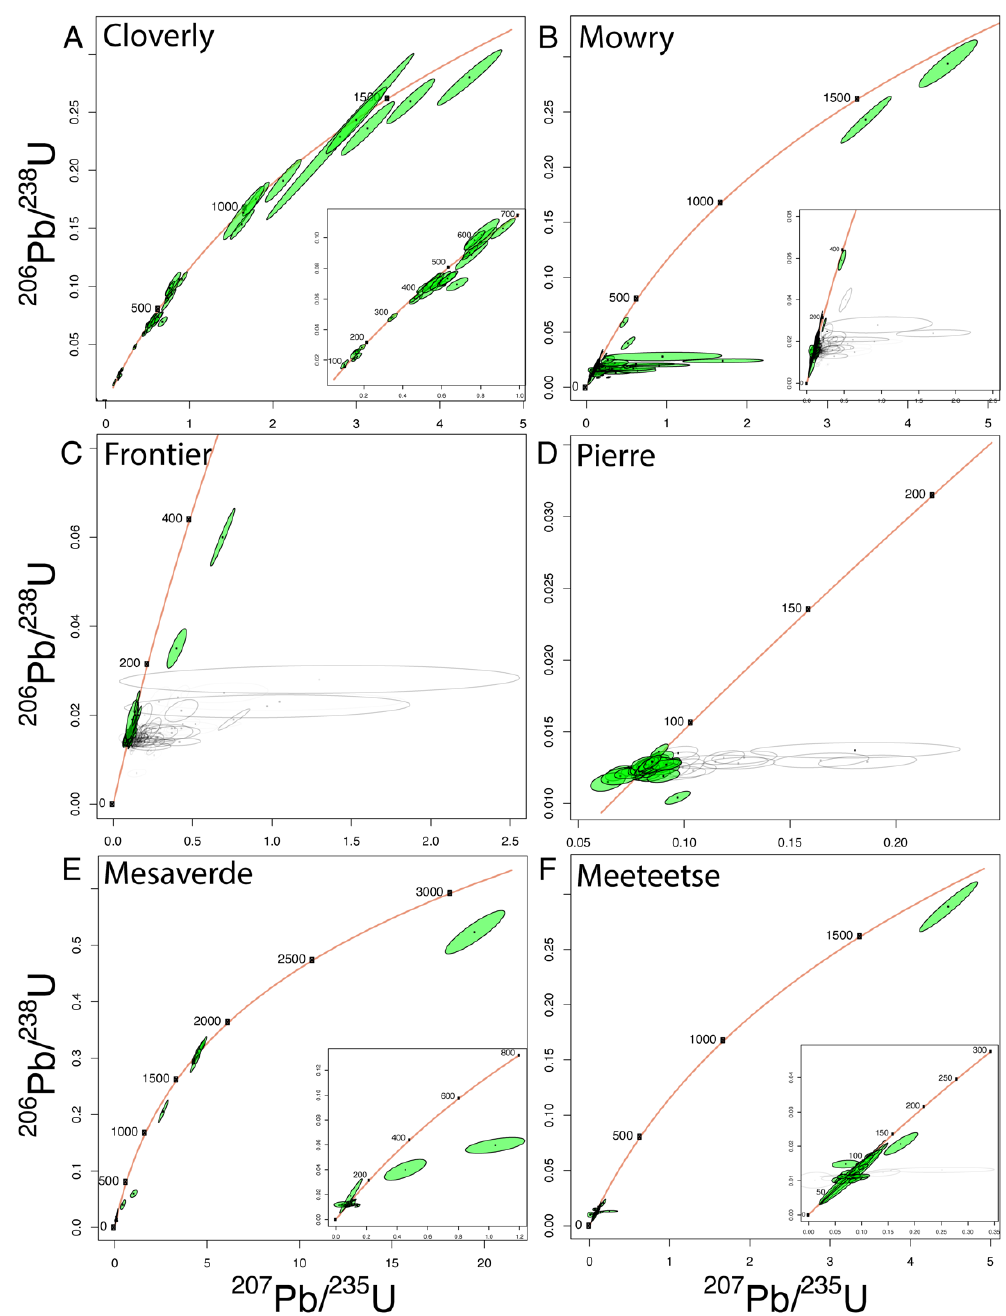
Figure 4. Wetherill concordia diagrams for each sampled unit, ( A – F ) (Cloverly, Mowry, Frontier, Pierre, Mesaverde and Meeteetse, respectively). Inset plots show most densely populated analyses. Discordant ellipses removed for visualization.